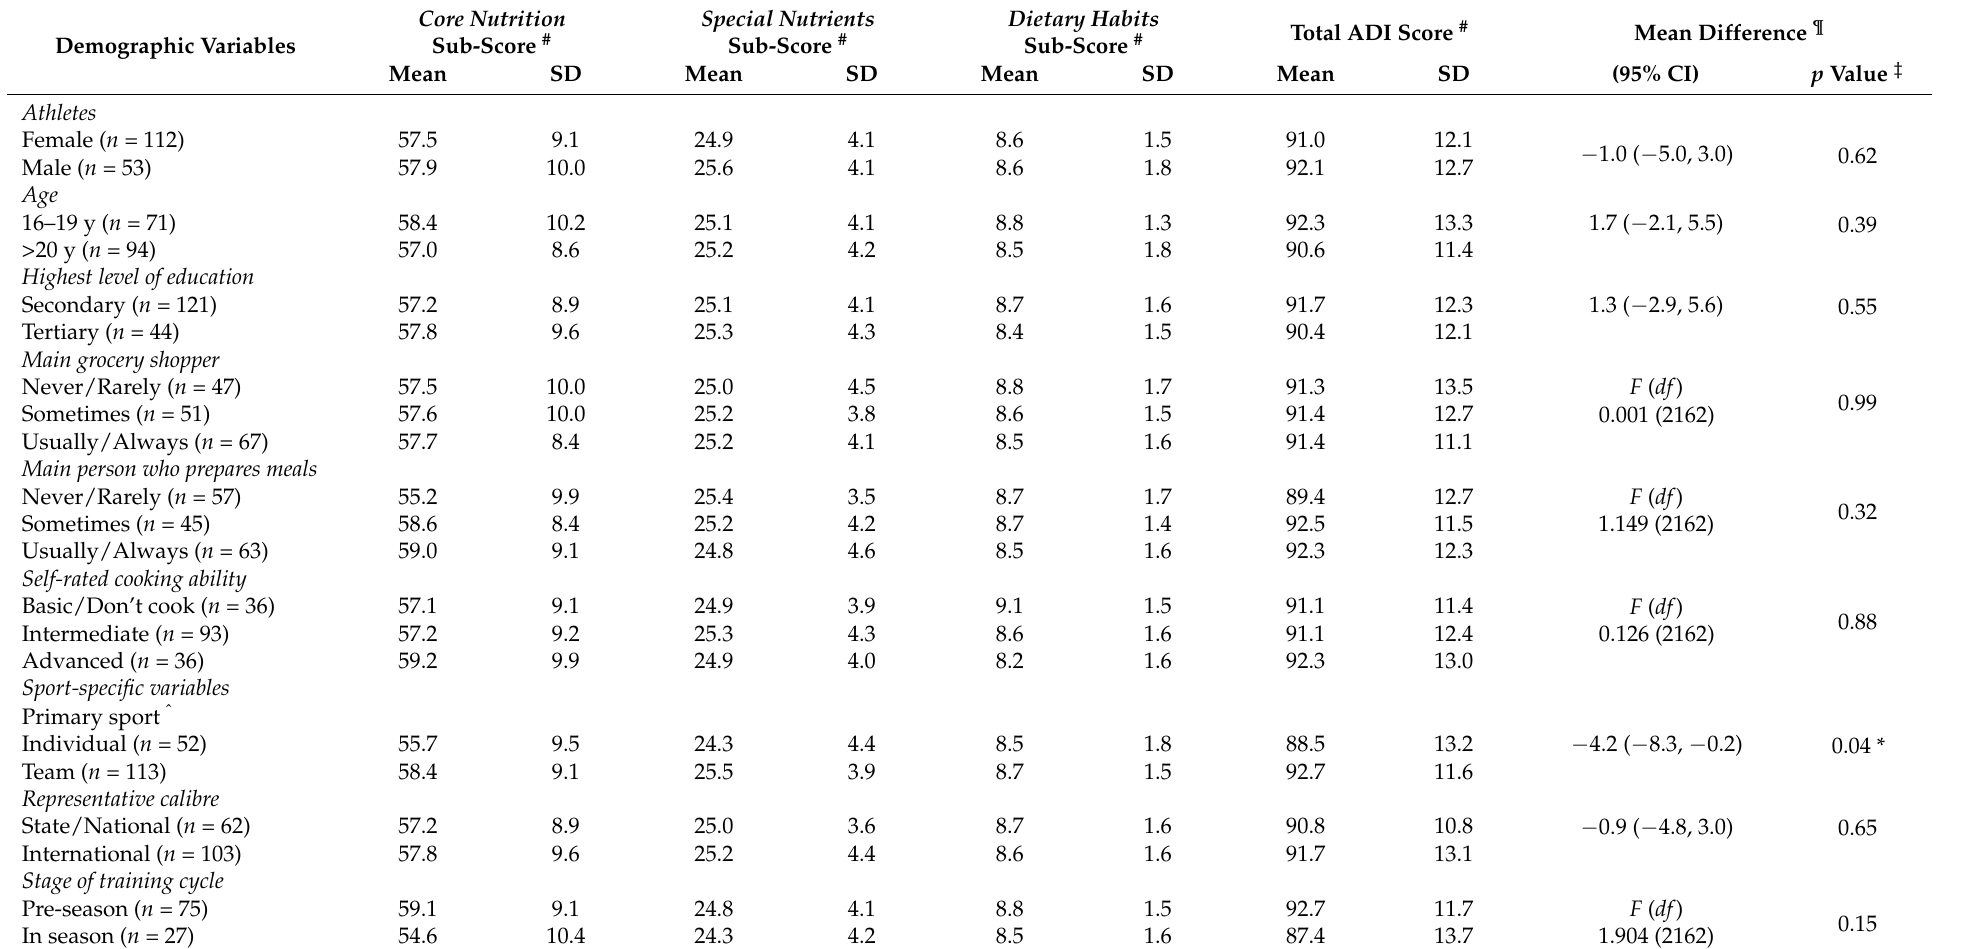
Table 4. Mean total ADI scores and sub-scores for all athletes ( n = 165) and the difference in mean total ADI scores between groups based on demographics and sports-specific characteristics.